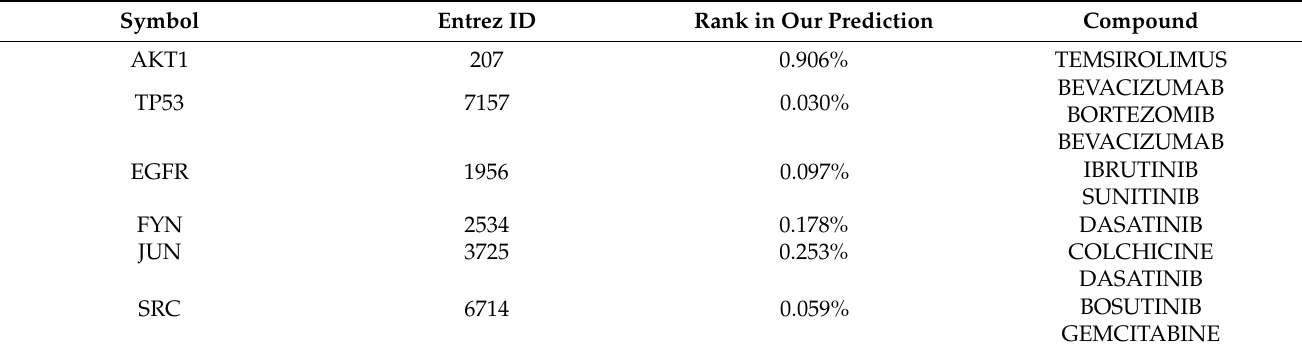
Table 1. Predicted compounds and rank of the selected